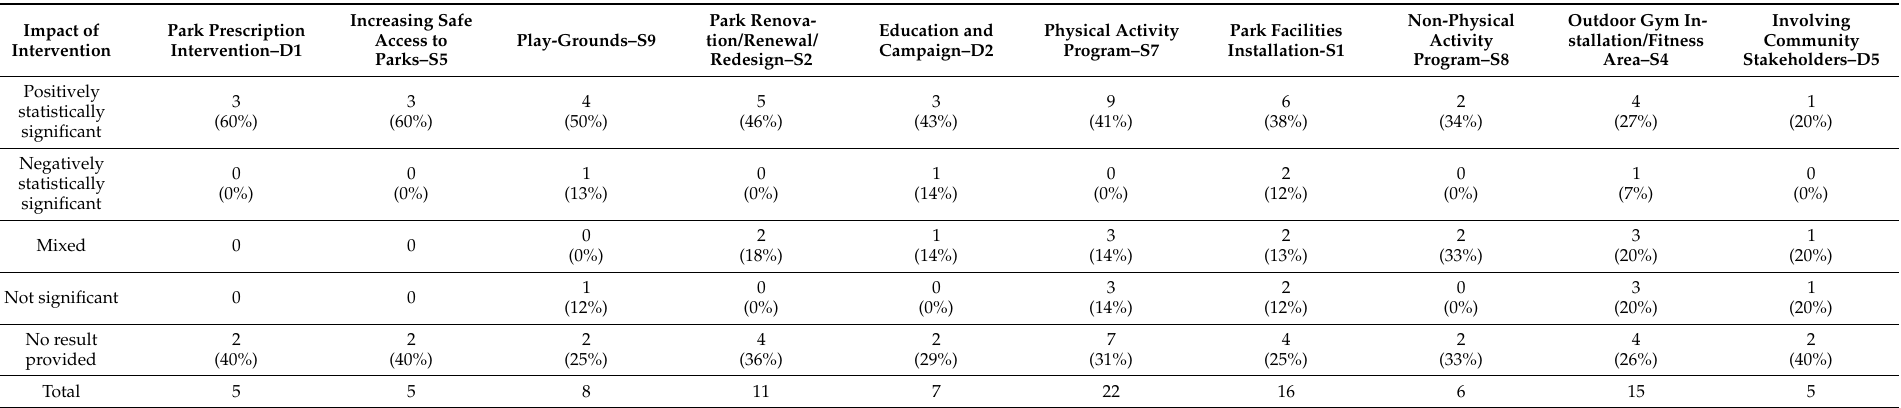
Table 4. Summary of empirical evaluated impacts of